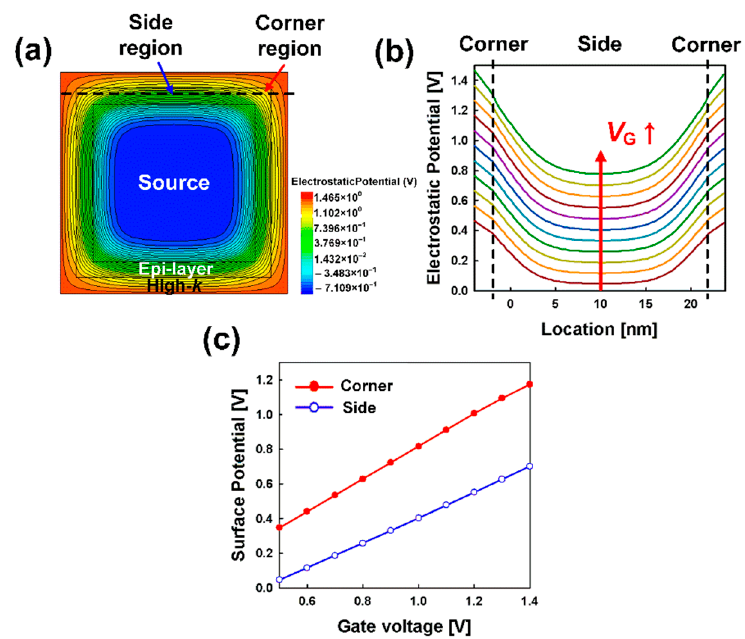
Figure 6. ( a ) 2D contour of electrostatic potential distribution at V G = 1.5 V, ( b ) electrostatic potential of cut line as V G increases (0.5 V–1.5 V), ( c ) surface potential at the corner and side.